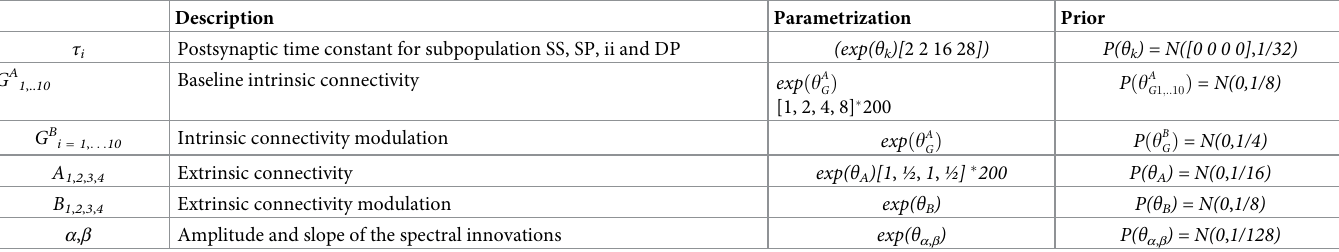
Table 1. Parameters of neural model (see Fig 1 for an illustration of the neural